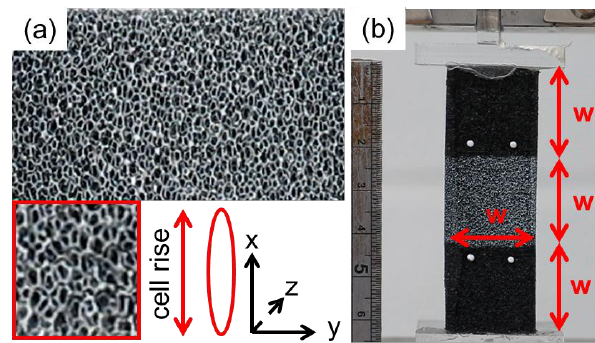
Figure 1. ( a ) PU foam and speckle pattern showing cell rise & orthotropic axes; ( b ) Cyclic test setup (w = sample width).